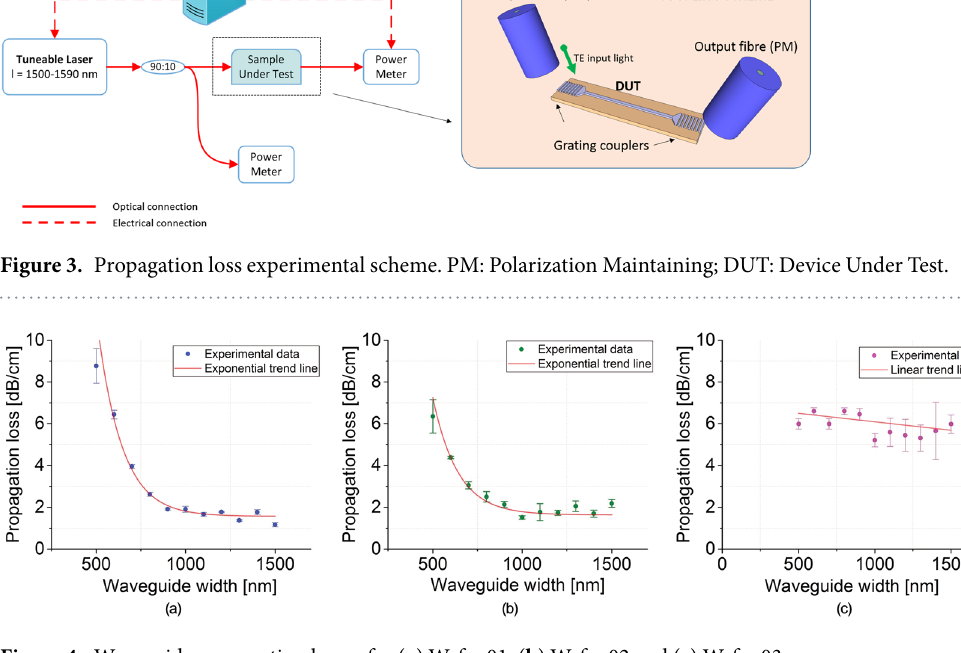
Figure 4. Waveguide propagation losses for ( a ) Wafer 01, ( b ) Wafer 02 and ( c ) Wafer